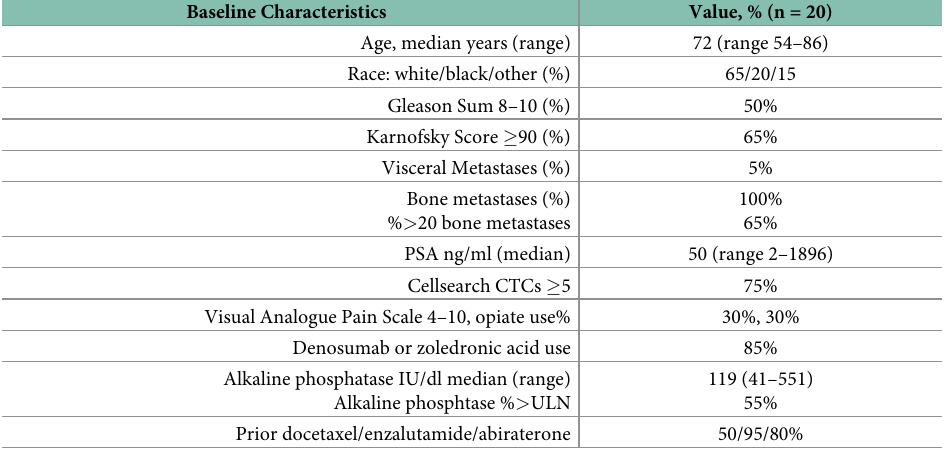
Table 1. Baseline characteristics of the patients